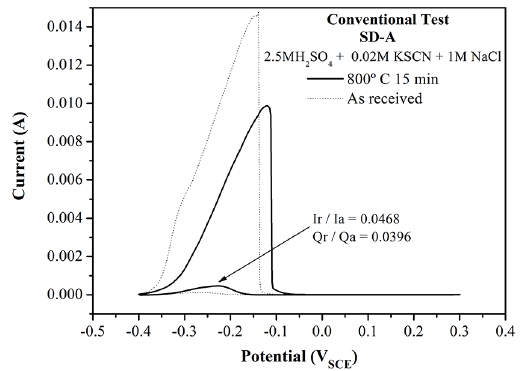
Figure 4. DL-EPR conventional tests in SD-A as received and aged at 800ºC for 15 minutes performed with 2.5 M H M KSCN + 1.0 M NaCl solution at room